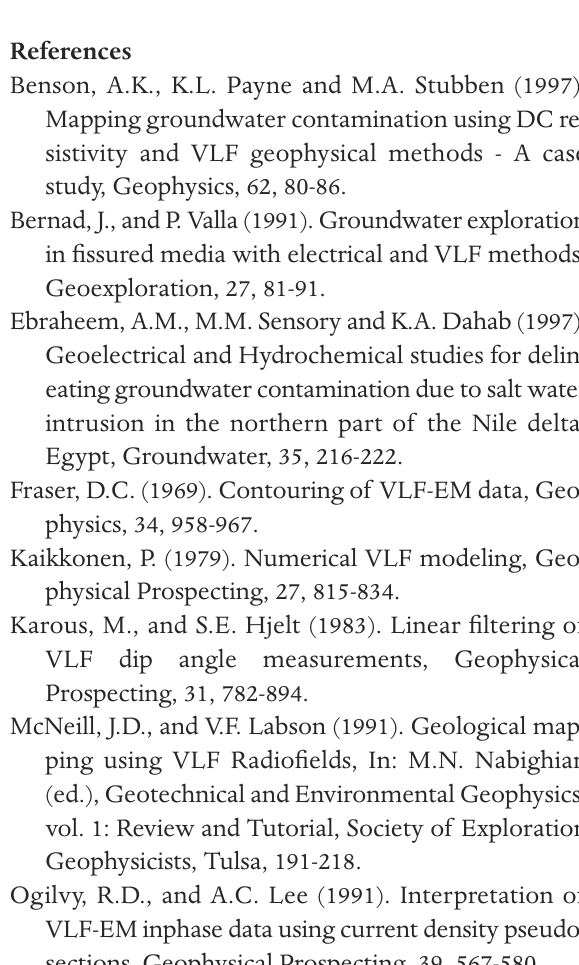
Figure 7. 1-D geoelectric section and drilling result in site